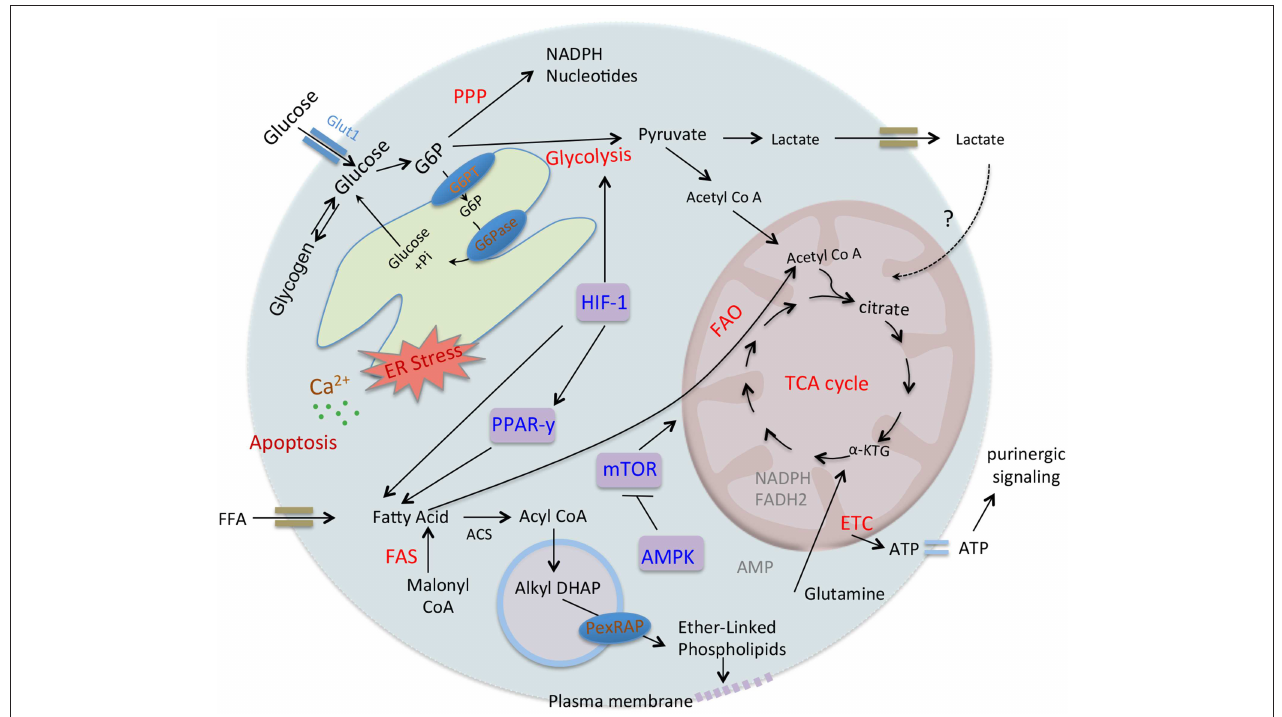
FIGURE 2 | Regulation of neutrophil metabolism. Neutrophil utilizes distinct metabolic pathways including glucose oxidation, glycogen breakdown and β -oxidation of fatty acids. After transport of glucose in the cytosol, hexokinase converts it to G6P that participate in different pathways like glycolysis, PPP, glycogen synthesis, or ER cycling. Glycolysis converts glucose to pyruvate that can further utilize in TCA cycle or forms lactate. G6PT and G6Pase regulate recycling of G6P in ER and disruption of glucose/G6P balance and ER stress due to G6PT or G6Pase- β deficiencies result in impaired energy homeostasis, functions, and survivals of neutrophils. While FFA gets transport to the cytosol and autophagy also release FFA that undergoes β -oxidation and provides a high level of ATPs through mitochondrial OxPHOS pathway and regulates neutrophil differentiation. On the other hand, in neutrophils FAS and PexRAP produce peroxisomal lipids that get incorporated into the plasma membrane and thus maintaining membrane integrity and viability. Mitochondrial OxPHOS provides ATPs that also drives purinergic signaling in neutrophils. Transcriptional regulator HIF-1 α regulates glucose transport as well as enzymes involved in the glycolysis. HIF-1 α regulates PPARy, that also increases glucose uptake and regulates fatty acid metabolism. Interestingly, over-activation of PPARy in diverse diseases leads to defective energetics and functions of neutrophils. mTOR functions as a master regulator of mitochondrial metabolism and also regulates purinergic signaling. AMPK that senses AMP-ATP levels also controls neutrophil metabolism and